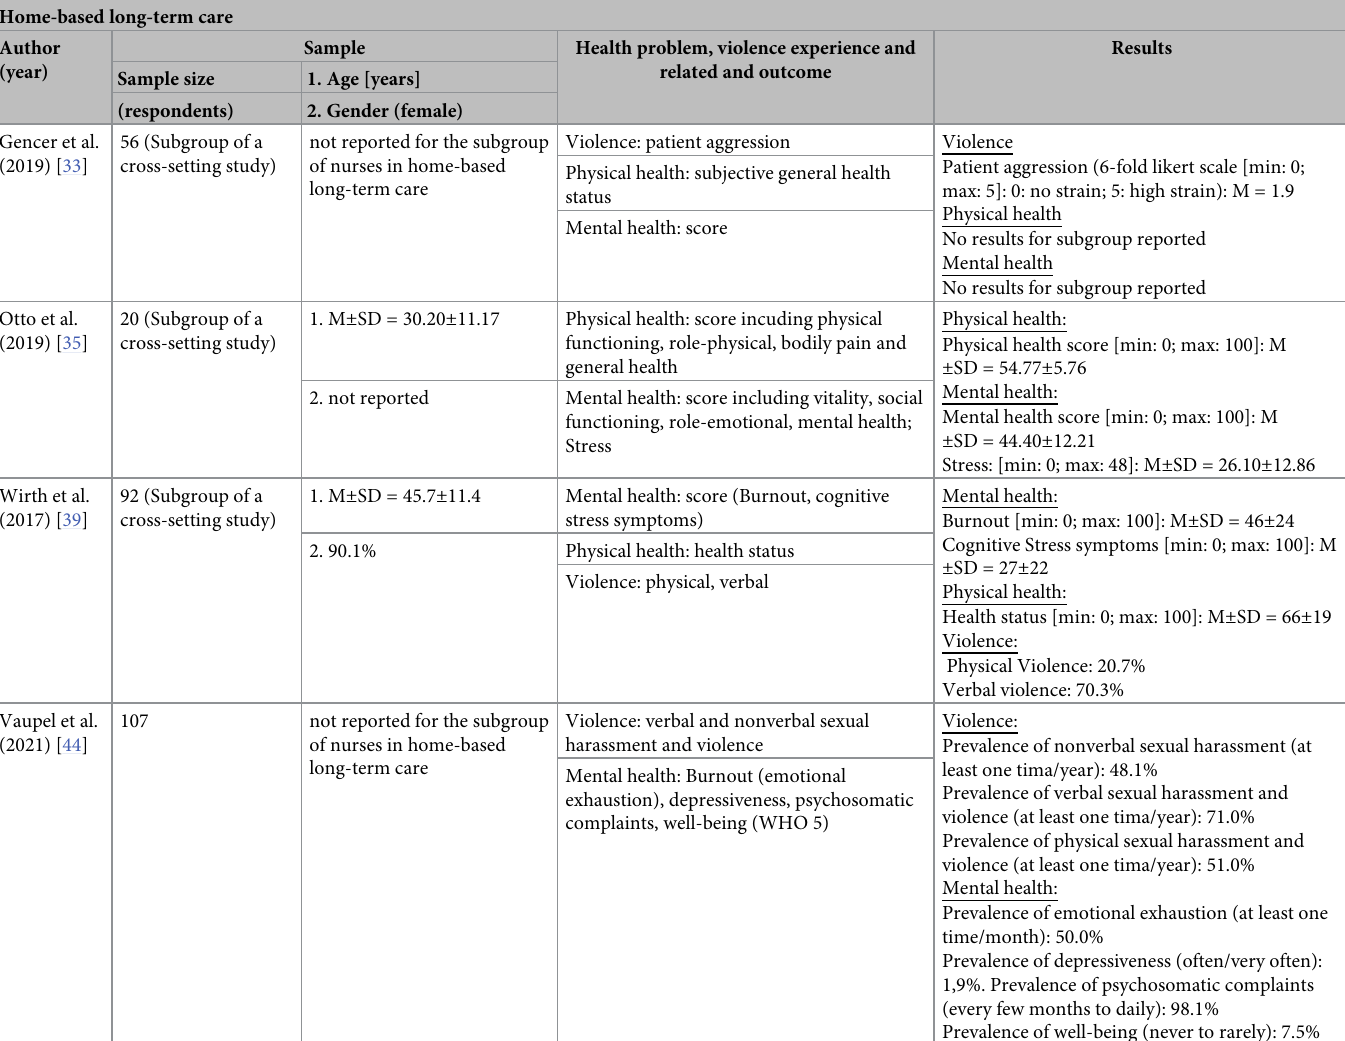
Table 4. Home-based long-term care—Summary of the studies included in the